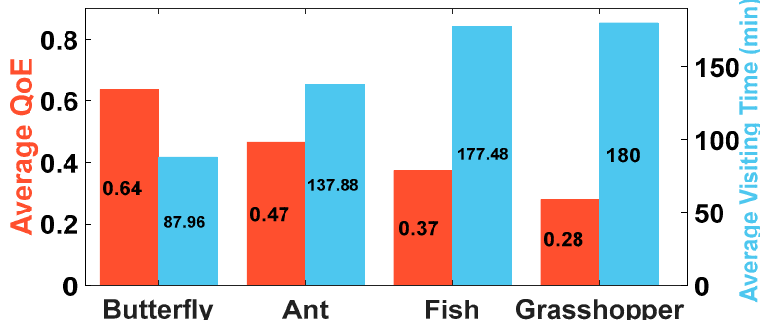
Figure 6. Average QoE and average visiting time for all the visiting styles.